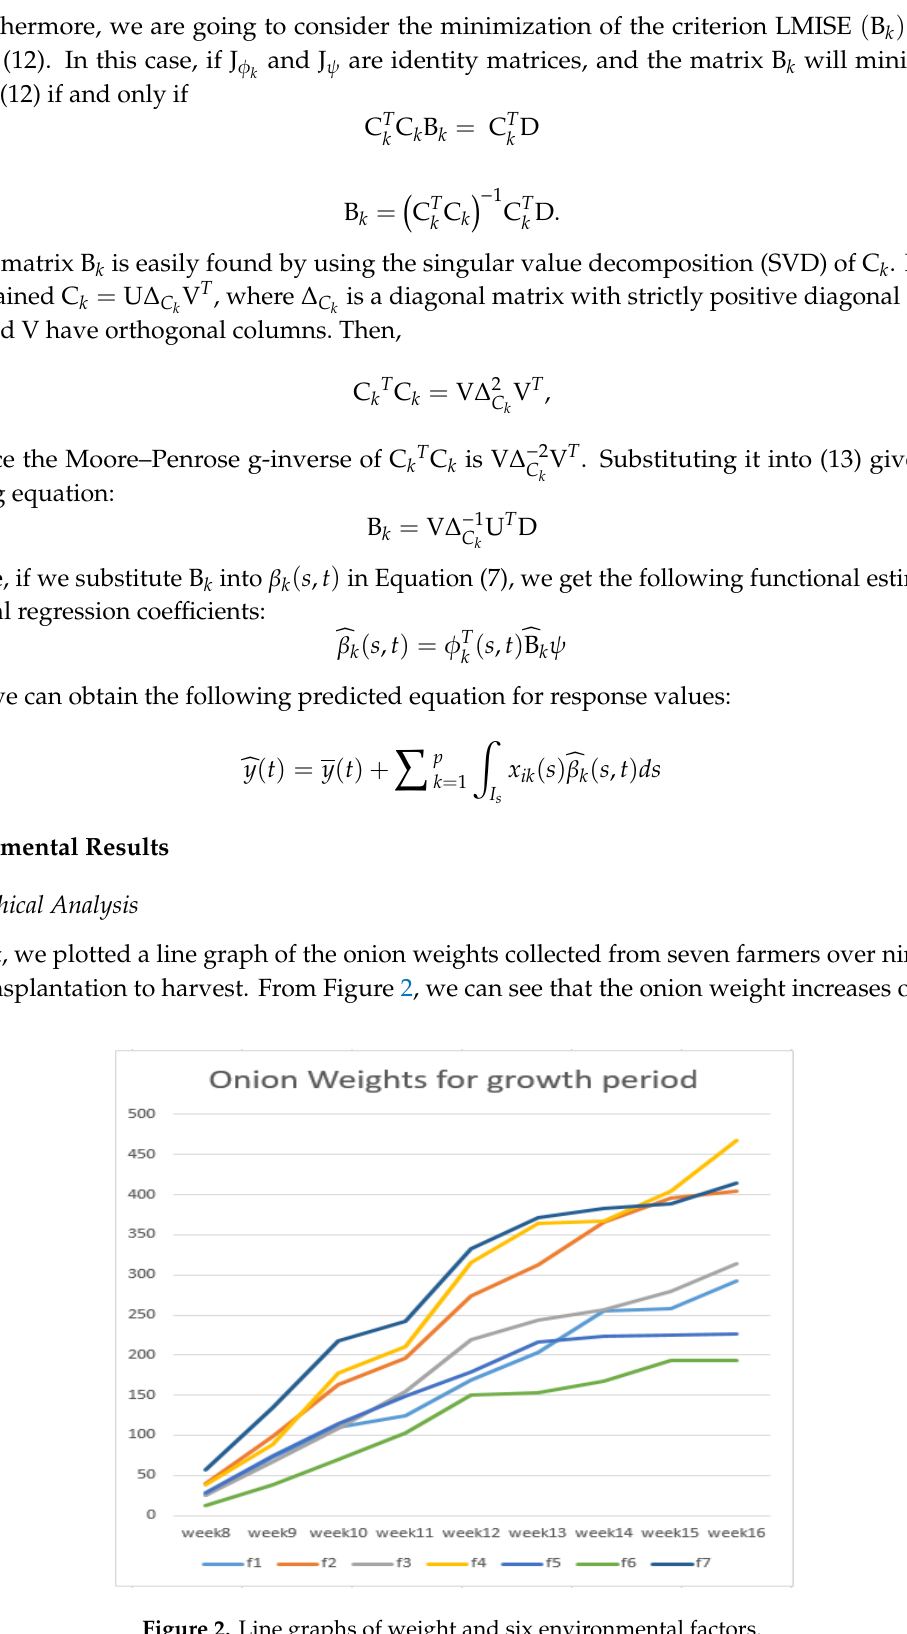
Figure 2. Line graphs of weight and six environmental factors.